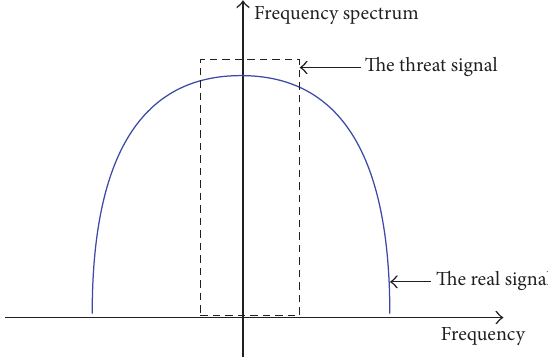
Figure 1: Threat signal of partial frequency band.